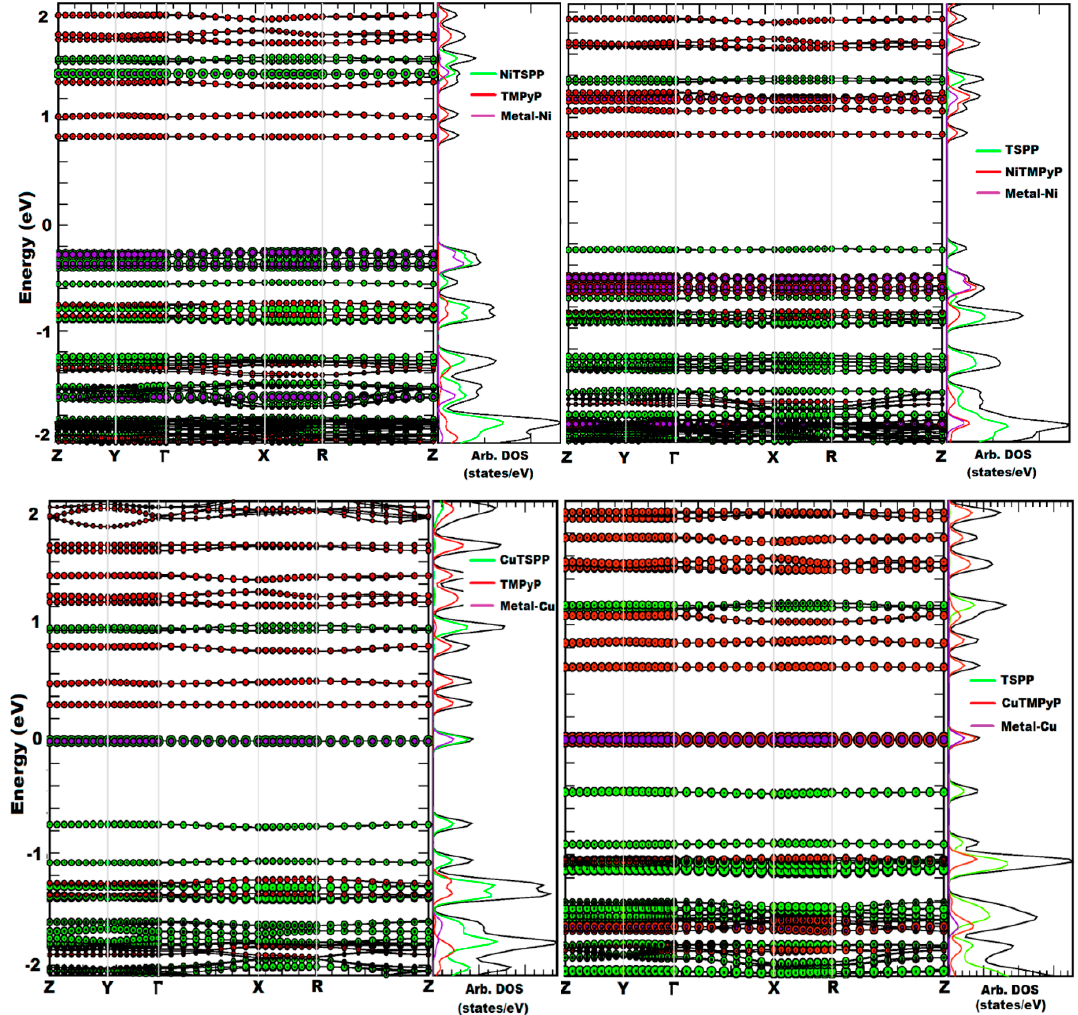
Figure 3. Projected density of states and the band structure for the H 2 TMPyP:NiTSPP, NiTMPyP:H 2 TSPP, H 2 TMPyP:CuTSPP, and CuTMPyP:H 2 TSPP crystals computed from DFT. The Fermi level (Ef) is set at zero. The high symmetry points of the Brillouin zone are as follows, G = (0,0,0), Z = (0,0,0.5), Y = (0,0.5,0), X = (0.5,0,0), and R = (0.5,0.5,0.5). Reproduced from reference [49] published by The Royal Society of Chemistry.